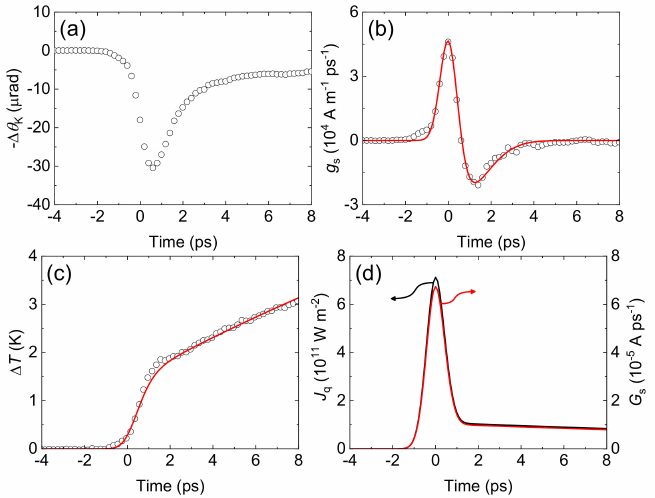
Figure 2. The spin generation on FM. ( a ) The Kerr rotation due to the ultrafast demagnetization of FM with the probe on the sap side of the sap/Pt(10)/[Co/Ni](3.8)/Cu(100)/MgO(3) sample. The ultrafast demagnetization data is nearly identical with either Au or Pt capping on top of Cu. ( b ) The bulk spin generation rate on FM obtained from the time derivative of the demagnetization data of ( a ) (black circles). The red line is a fitting with a Gaussian function. ( c ) The temperature increase of the Cu surface of the sap/Pt(10)/[Co/Ni](3.8)/Cu(100)/MgO(3) sample. Black circles are data points obtained from time-domain thermoreflectance (TDTR), and the red line is the result of the thermal modeling. ( d ) The black line is the heat current at the FM/Cu interface estimated from the thermal modeling of ( c ). The red line is the interfacial spin generation rate at the FM/Cu interface obtained by the Equation (2) in the main text.